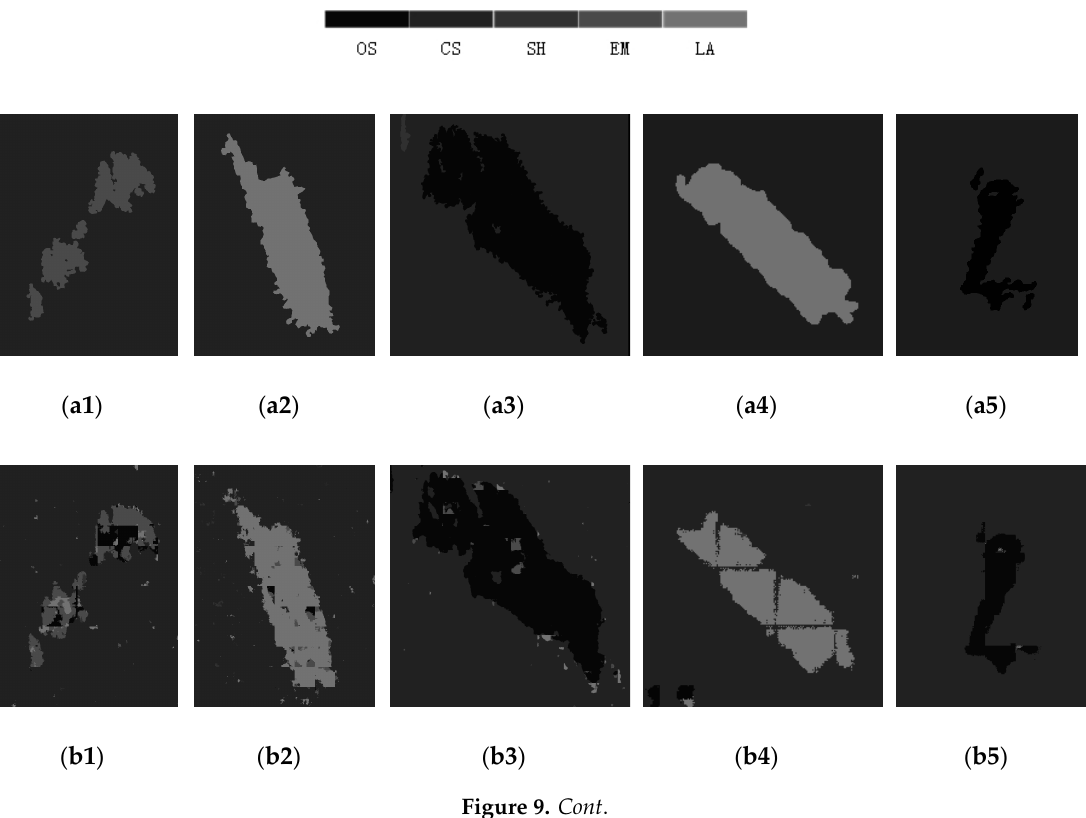
Table 4. Number of samples of each category.